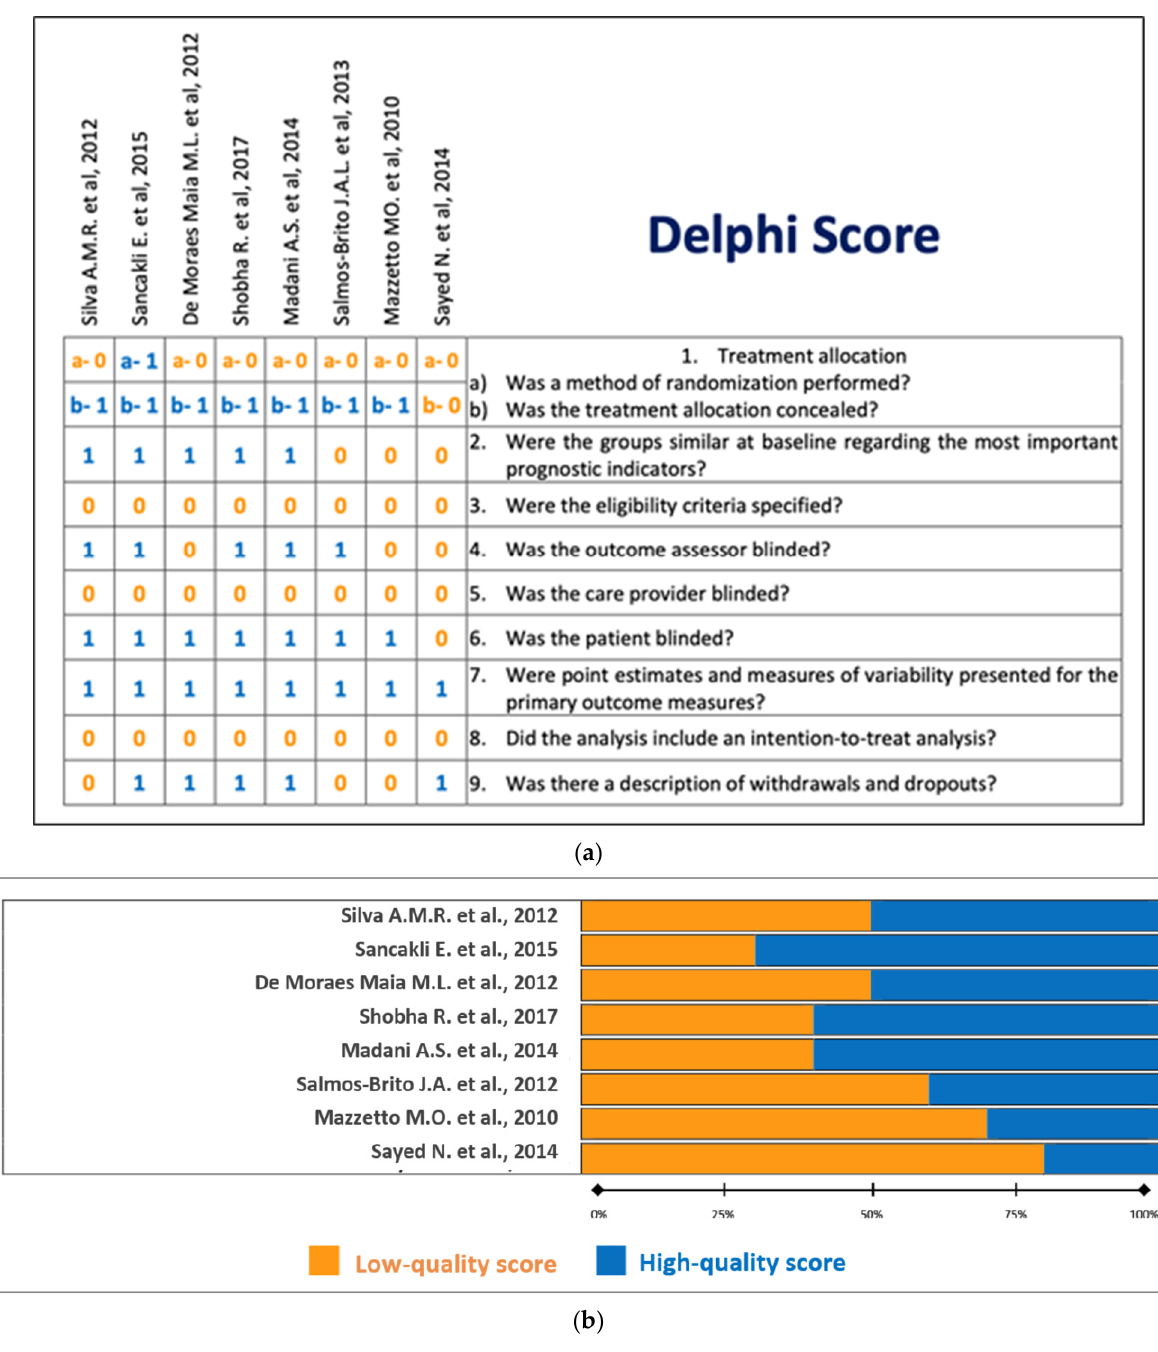
Figure 3. ( a ) Delphi list summary: review authors’ judgments according to each of its item’s Delphi score for each included study. ( b ) Delphi score graph: review authors’ judgments according to each of its items Delphi score presented as percentages across all included.